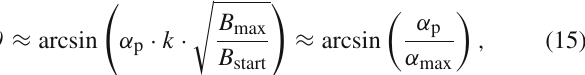
results from the adiabatic transformation towards the spec-